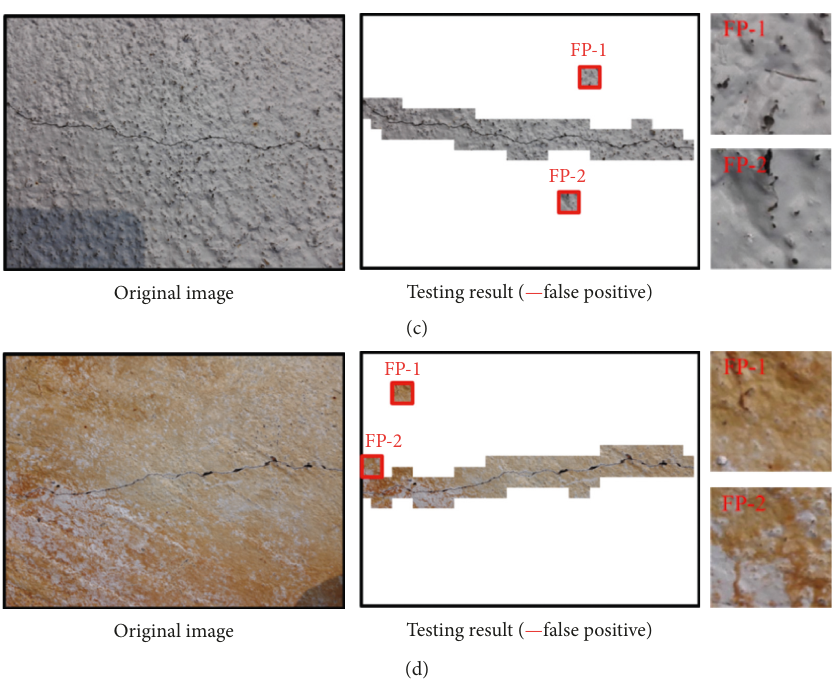
Figure 12: Damaged surfaces: (a) shadowed surface; (b) surface with holes; (c) rough surface; (d) rusty surface.